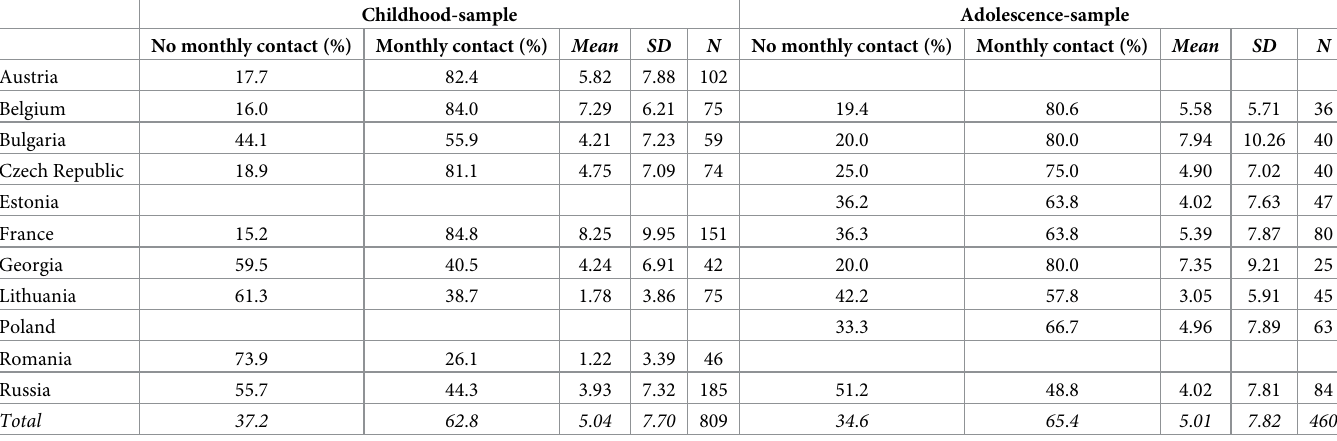
Table 1. Descriptive statistics of frequency of monthly nonresident father-child contact by country, binary and continuous measure, percentage or mean/standard deviation (complete cases). Childhood-sample